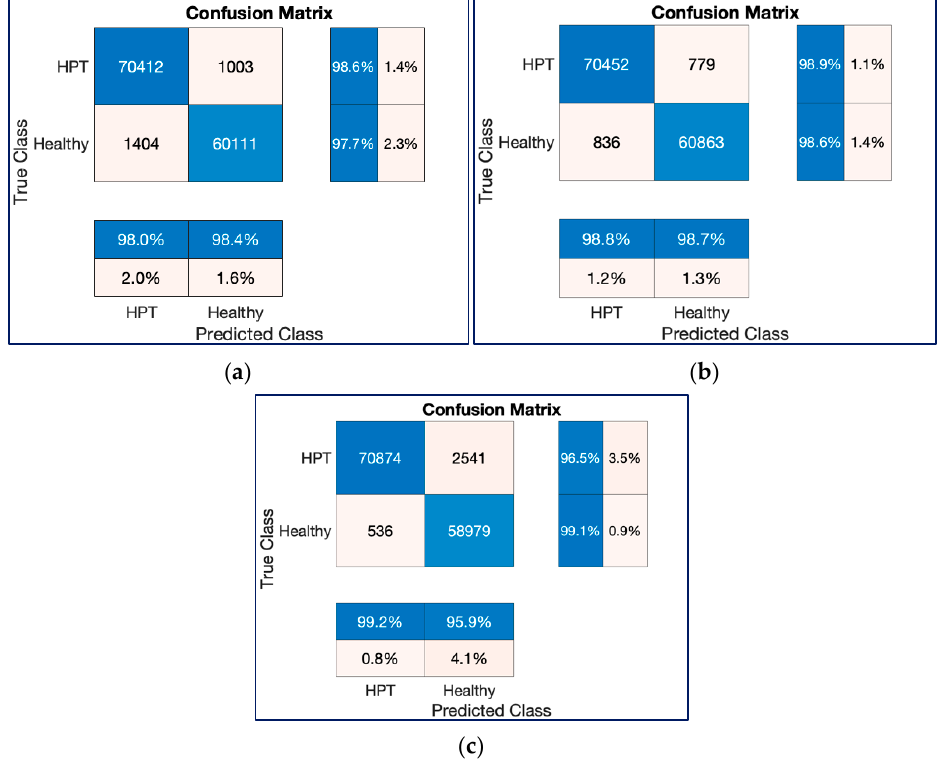
Figure 19. Cumulative confusion chart results for classification processes with 132,968 spectrogram images on the 10 ‐ FCV. ( a ) ResNet18, ( b ) ResNet50, ( c ) ConvMixer.